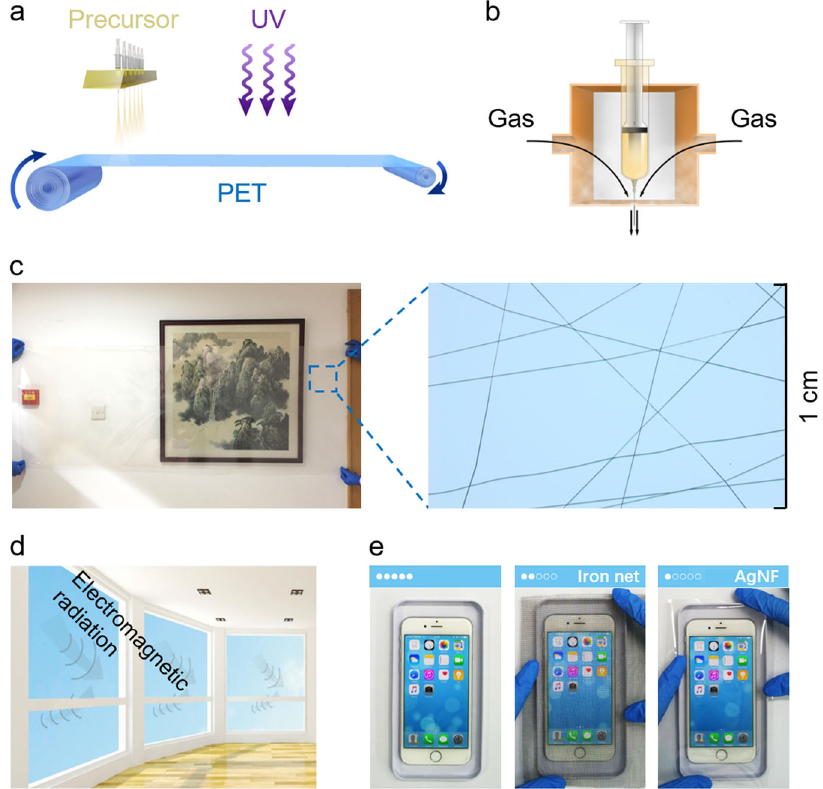
Fig. 1 Schematic of blow-spinning and material exhibition. a Fabrication of AgNF includes continuous blow-spinning and in-situ UV irradiation. b Partial enlarged detail of needle module shows the principle of blow-spinning. c A photograph of a window-scale (3 m × 1 m) AgNF EMI shielding fi lm and its optical microscope image, d which could be considered as an EMI shielding functional material in modern architecture with large expanse of glass. e An EMI shielding demo consist of a grounded metal salver and different cover fi lms include iron net and